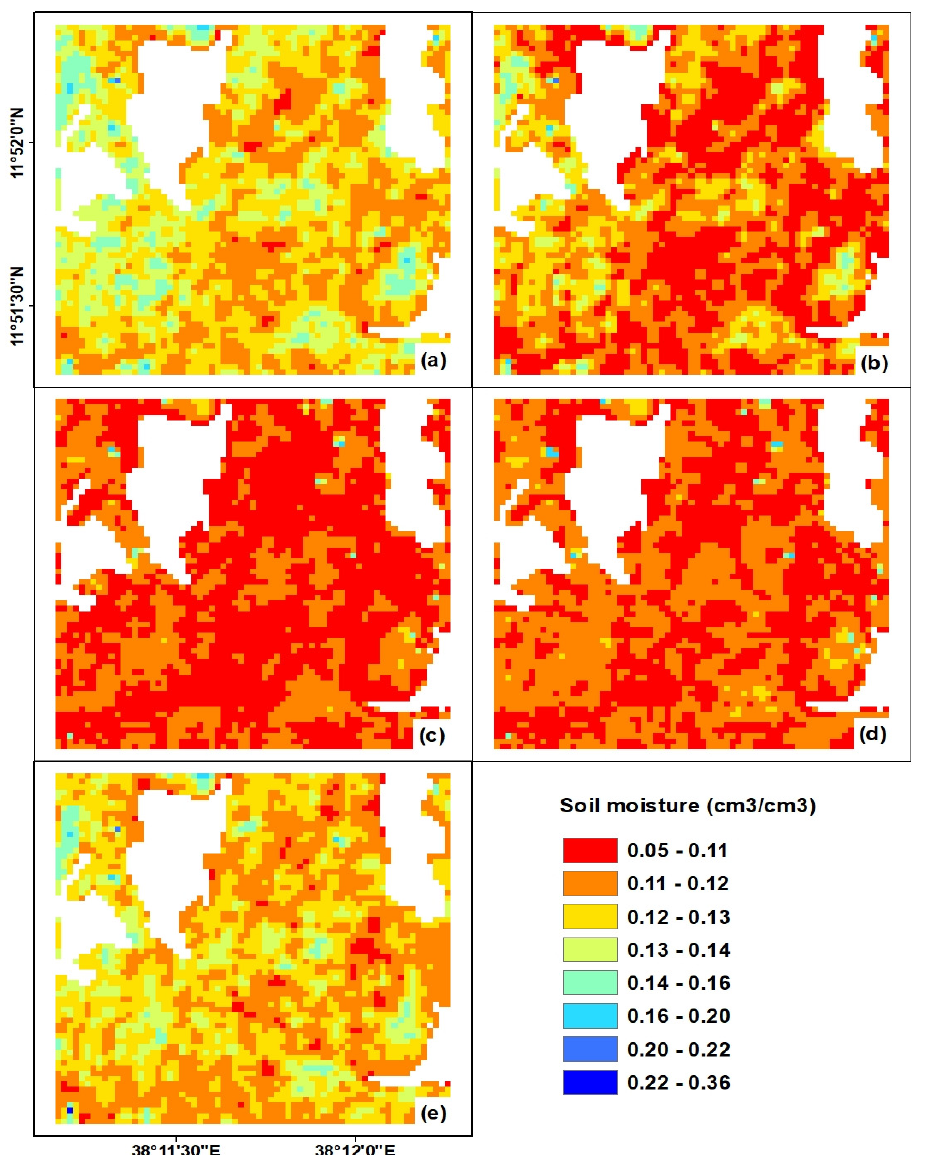
Figure 11. Spatio-temporal estimates of soil moisture based on the ANN method and σ soil _ vv , h rms , and l ef f input variables for: ( a ) 22 November 2016, ( b ) 29 November 2016, ( c ) 16 December 2016, ( d ) 23 December 2016, and ( d ) 2 February 2017.